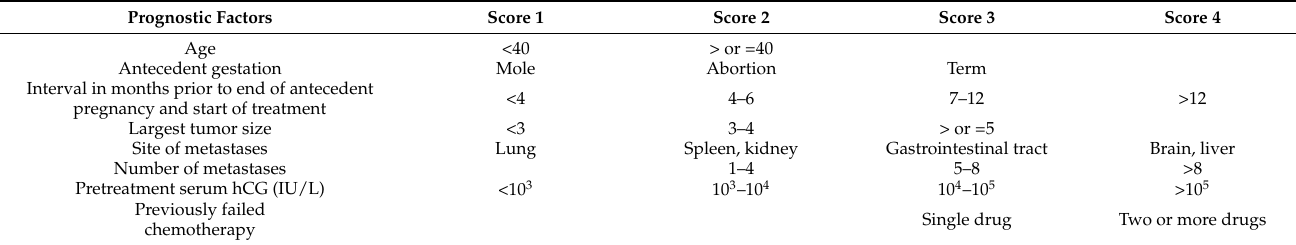
Table 2. FIGO score, 2000 scoring